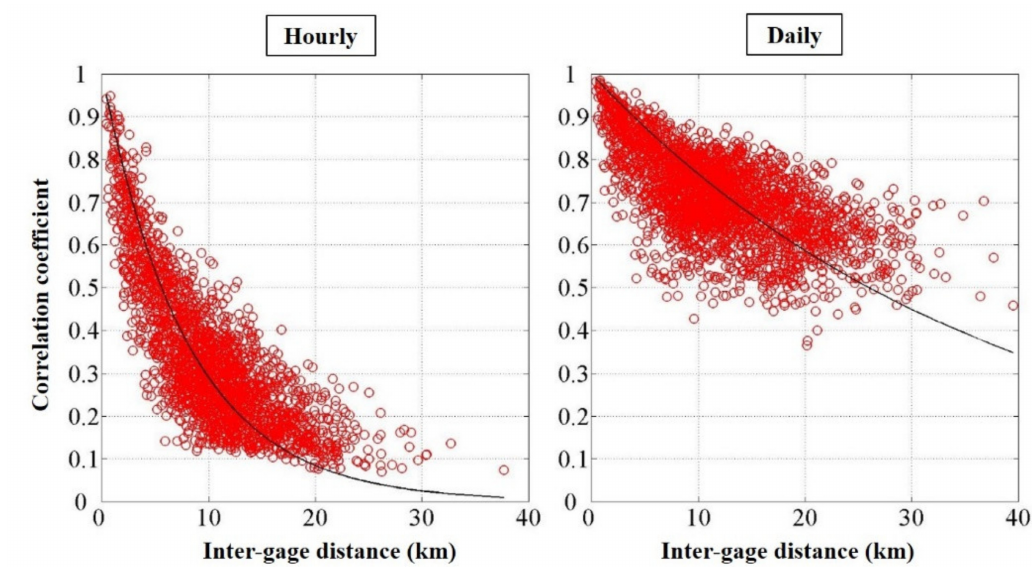
Figure 2. Empirical spatial correlation function of rainfall at hourly (left) and daily (right) scales using the Calcasieu network observations over the study period (January 2017 through August